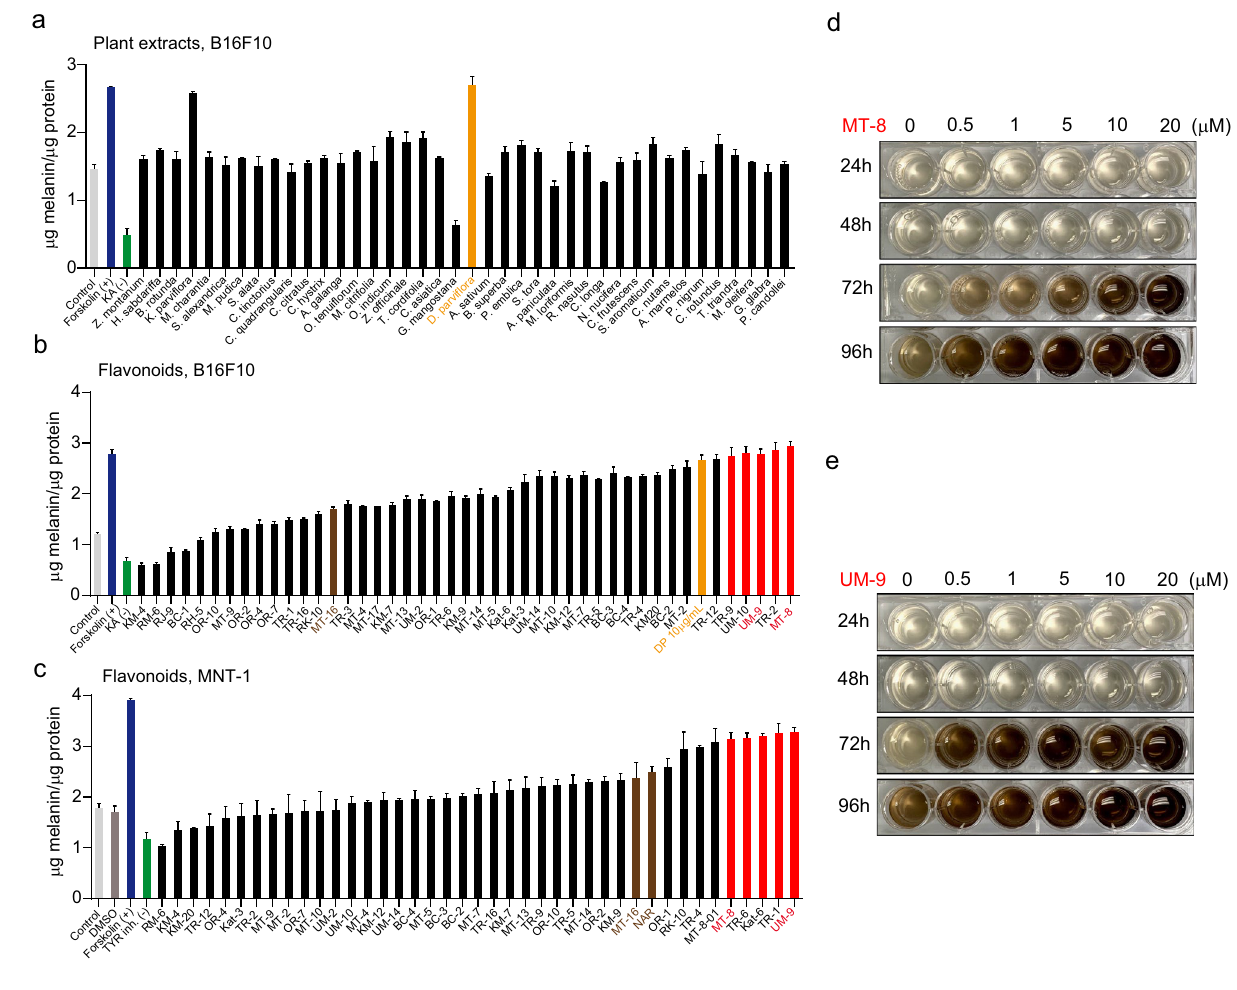
Figure 2. Flavonoid compound screening in B16F10 and MNT-1 cells using effect on melanin content as read-out. ( a ) Effect of different plant extracts including D. parviflora extract on the melanin content of B16F10 cells. Forskolin was used as positive control. KA (Kojic acid = 5-Hydroxy-2-(hydroxymethyl)-4H-pyran-4-one) was used as negative control. Data are shown as mean values ± SD (n = 3, each). ( b ) Effect of different flavonoids on the melanin content of B16F10. Forskolin was used as positive control. KA was used as negative control. MT-16 = NAR = naringenin was shown before to block TPCs. The data are shown in the sequence of ascending effect. Top five hits are highlighted in red and D. parviflora (DP) extract is highlighted in yellow. Data are shown as mean values ± SD (n = 3, each). ( c ) Effect of different flavonoids on the melanin content of MNT-1 cells. Forskolin was used as positive control. 4-Butyl-resorcinol (TYR inh.) was used as negative control. The data are shown in the sequence of ascending effect. Top five hits are highlighted in red. In both B16F10 and MNT-1 cells the compounds UM-9 and MT-8 were consistently found to be among the top 5 hits. MT-16 and commercially available NAR (cat. #67604-48-2; Sigma) are highlighted in brown. Data are shown as mean values ± SD (n = 3, each). In all experiments the following concentrations of the compounds were used: Forskolin (10 µM), TYR inh. (10 µM), KA (10 µM), flavonoids (20 µM). In a-c mean values ± SEM are shown, (n = 3, each). ( d ) and ( e ) Examples of experiments showing the time and concentration dependent effects of MT-8 ( d ) and UM-9 ( e ) on melanin content in B16F10 cells. For quantification see Fig.